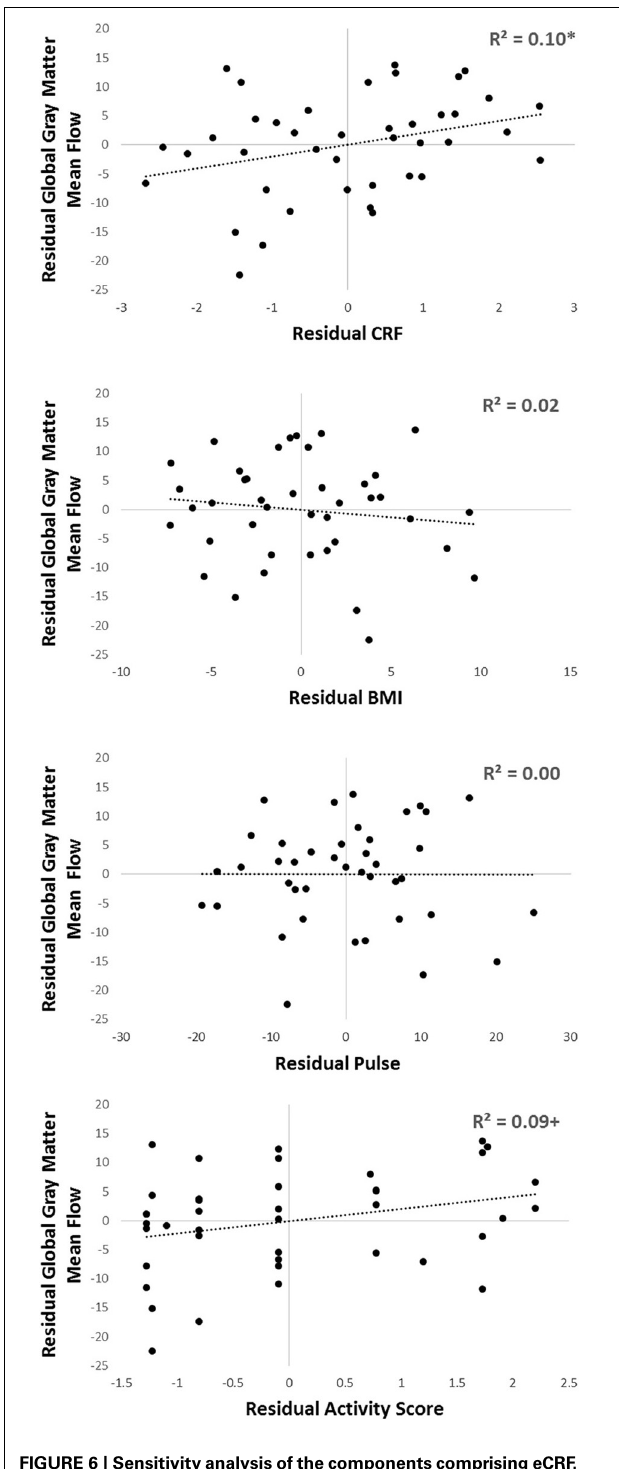
FIGURE 6 | Sensitivity analysis of the components comprising eCRF. Participantswereseparatedbygender,andthenintoolderoryoungergroups by median split. Within each of those four groups, residuals of eCRF, BMI, pulse, activity score, and global gray matter CBF were calculated by subtracting the group mean from each of the observed scores. Shown here are the residuals of eCRF (top), and its individual components (BMI, pulse, and activity score; shown below) correlated with the residuals of CBF. + p < 0 . 10, ∗ p < 0 . 05.